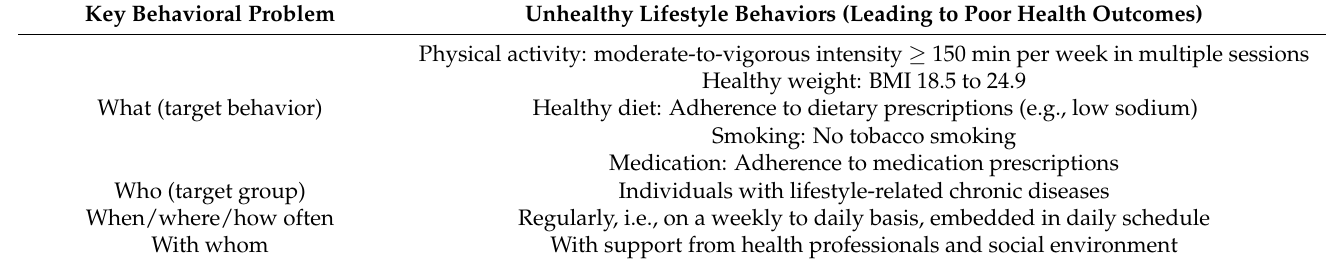
Table 1. Specification of the target behavior (Behavior Change Wheel steps 1 to 3). Table template adapted from S. Michie, L. Atkins, and R. West, The behaviour change wheel: a guide to designing interventions; UK: Silverback Publishing, 2014. Key Behavioral